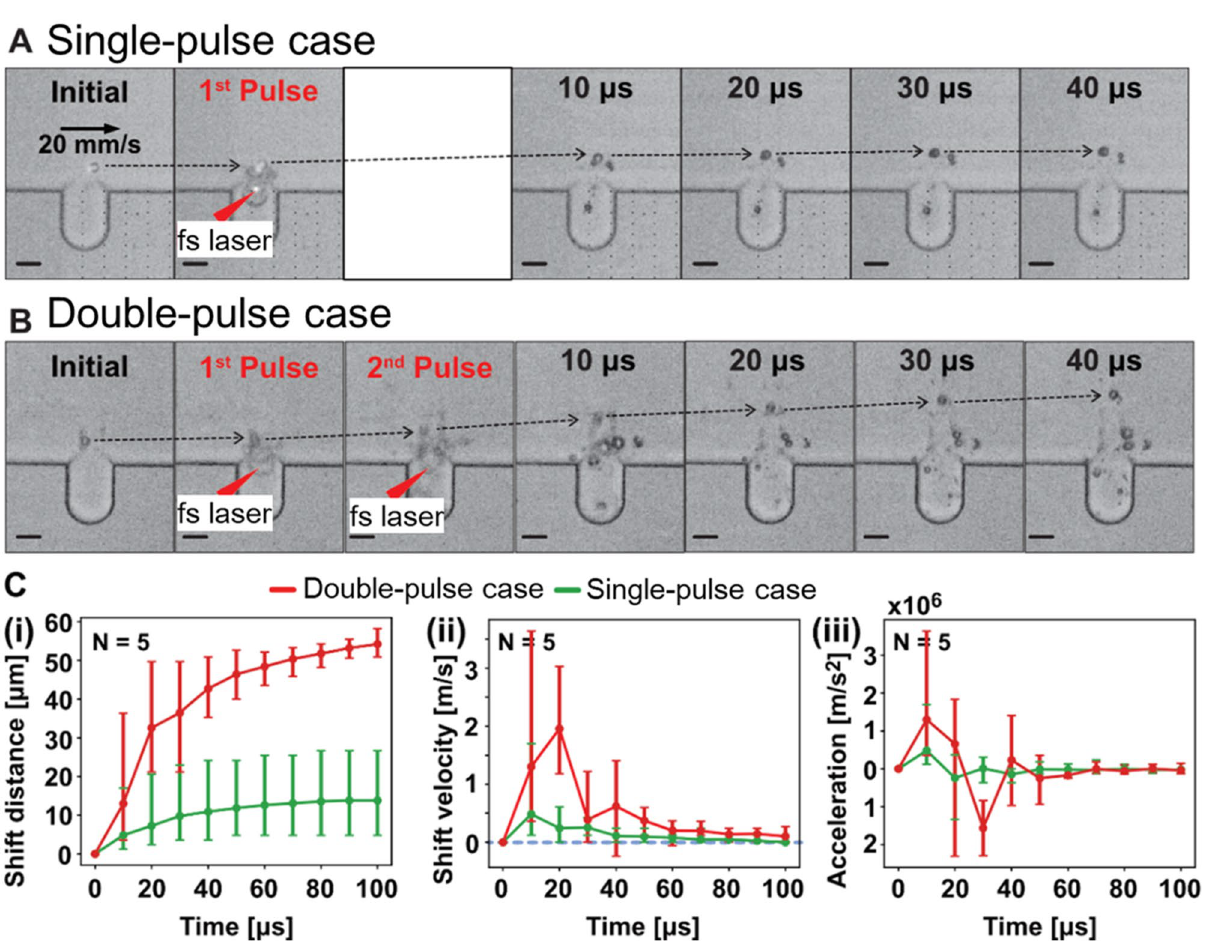
Figure 4. Effects of femtosecond-laser-induced impulsive force on the 10 μm polystyrene beads. ( A,B ) Shifted flow profile of 10 μm beads in response to ( A ) a single femtosecond pulse and ( B ) double femtosecond pulses. ( C ) Time series of (i) shift distance, (ii) velocity, and (iii) acceleration of the beads in single- or double-pulse cases within 100 μs. The scale bars represent 20 μm. The error bar is the standard deviation calculated from five sets of